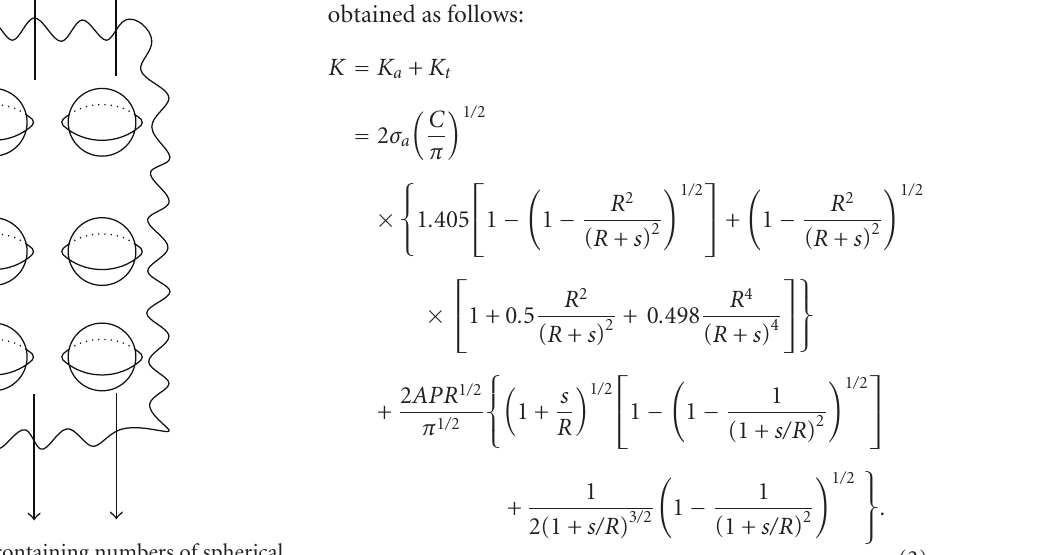
Figure 1: Floor plan of the model containing numbers of spherical particles with annular